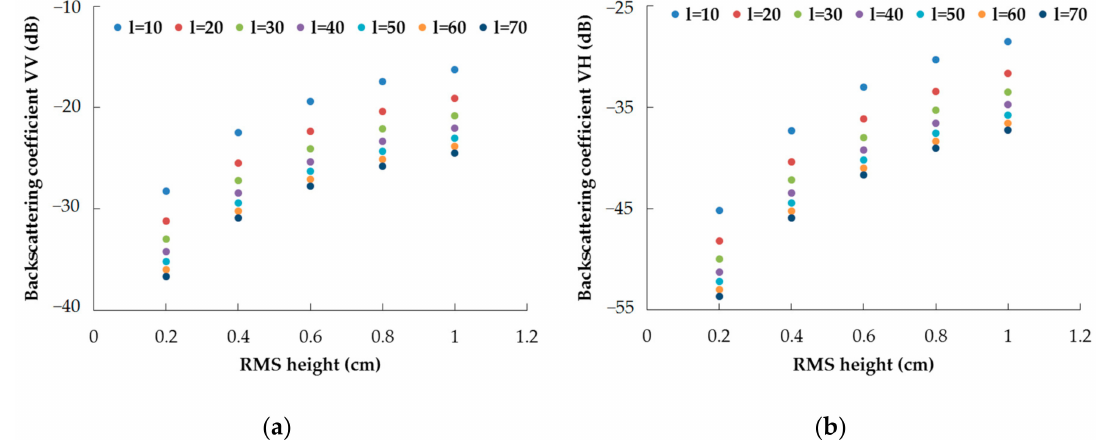
Figure 2. Responses of the backscattering coefficients and RMS height under different correlation lengths (10, 20, 30, 40, 50, 60, and 70 cm) when the soil moisture is 20%: ( a ) VV polarization; ( b ) VH